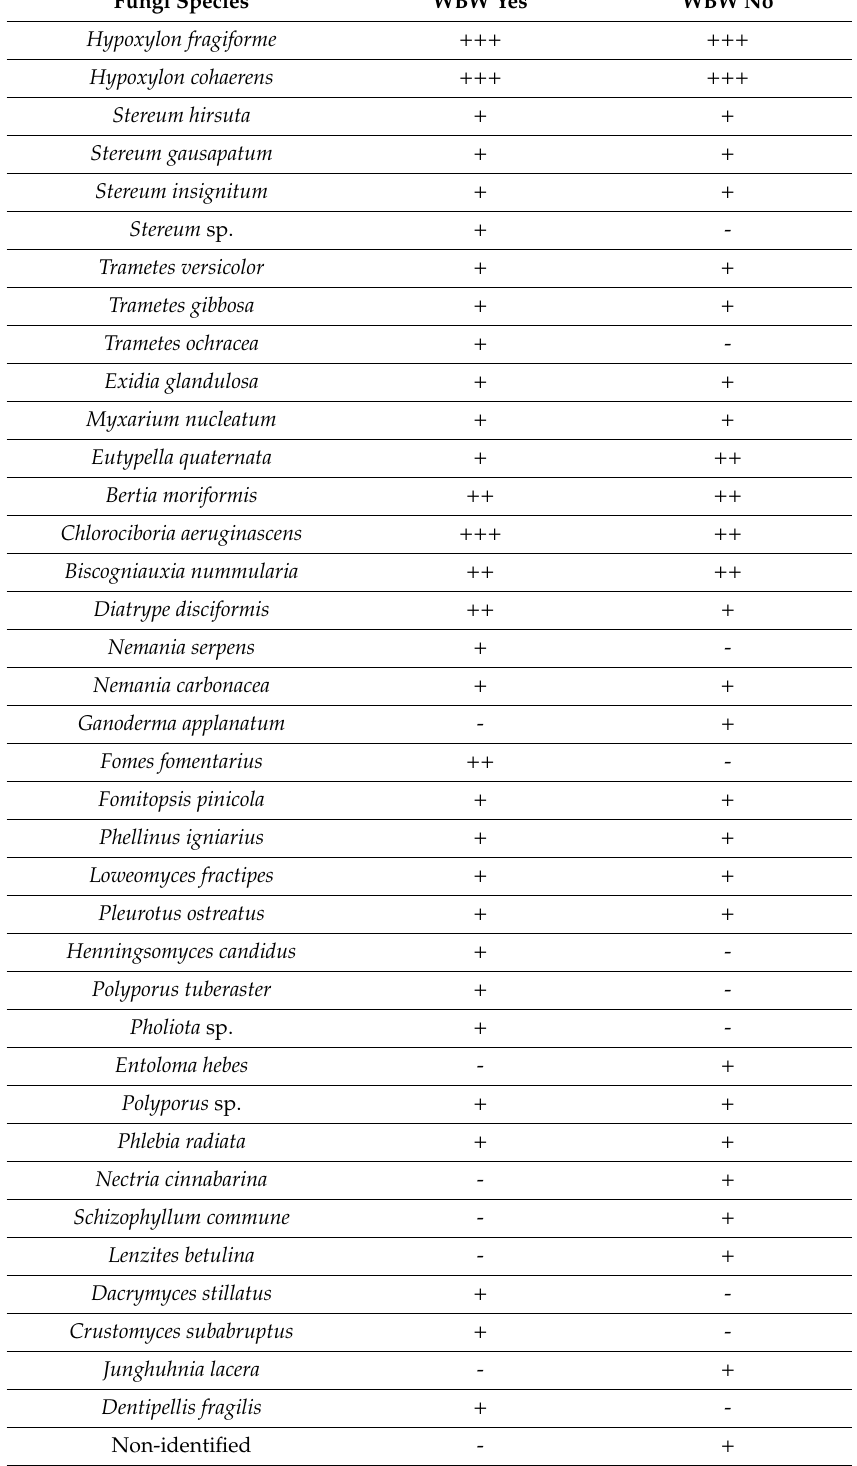
Table A3. Observed fungi species in WBW territories (WBW yes) and non-WBW territories (WBW no). Presence of a species is marked based on the number of transects and circular plots in which it appeared: − (0 times), + (1–5 times), ++ (6–10 times), and +++ (11–15